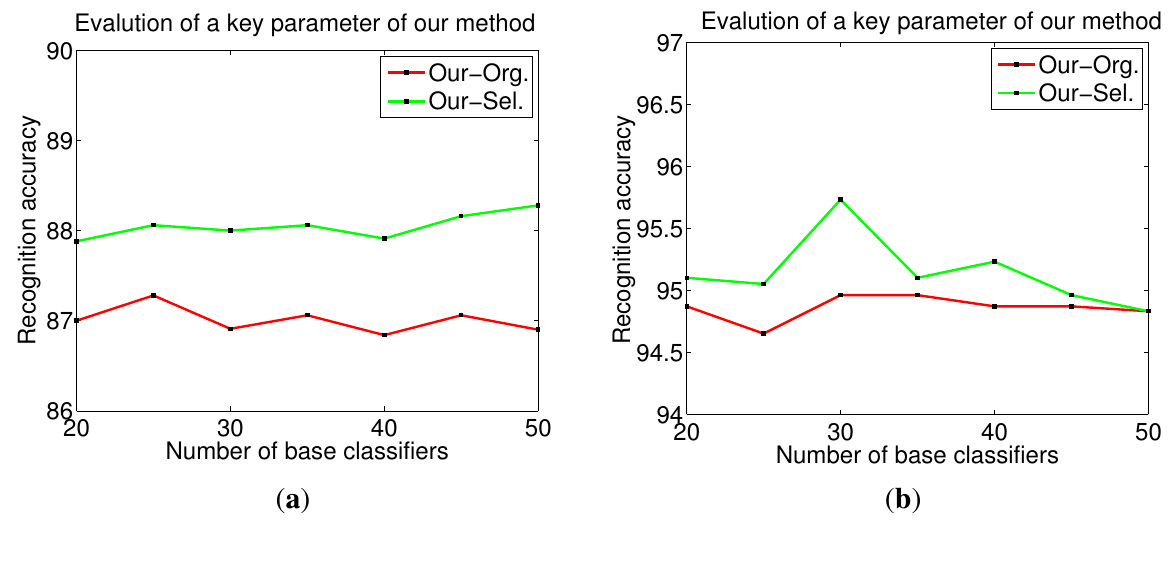
Figure 12. Influence of a key parameter (base classifier number) of our method on two databases: ( a ) ORL; ( b )